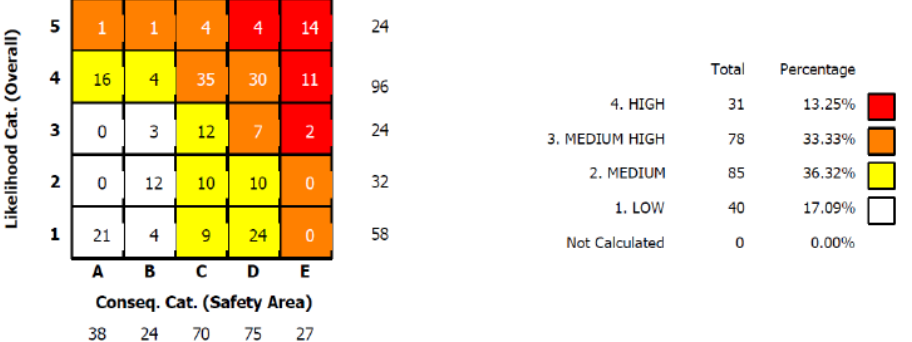
Figure 6. Risk assessment results of the equipment in ALK unit.